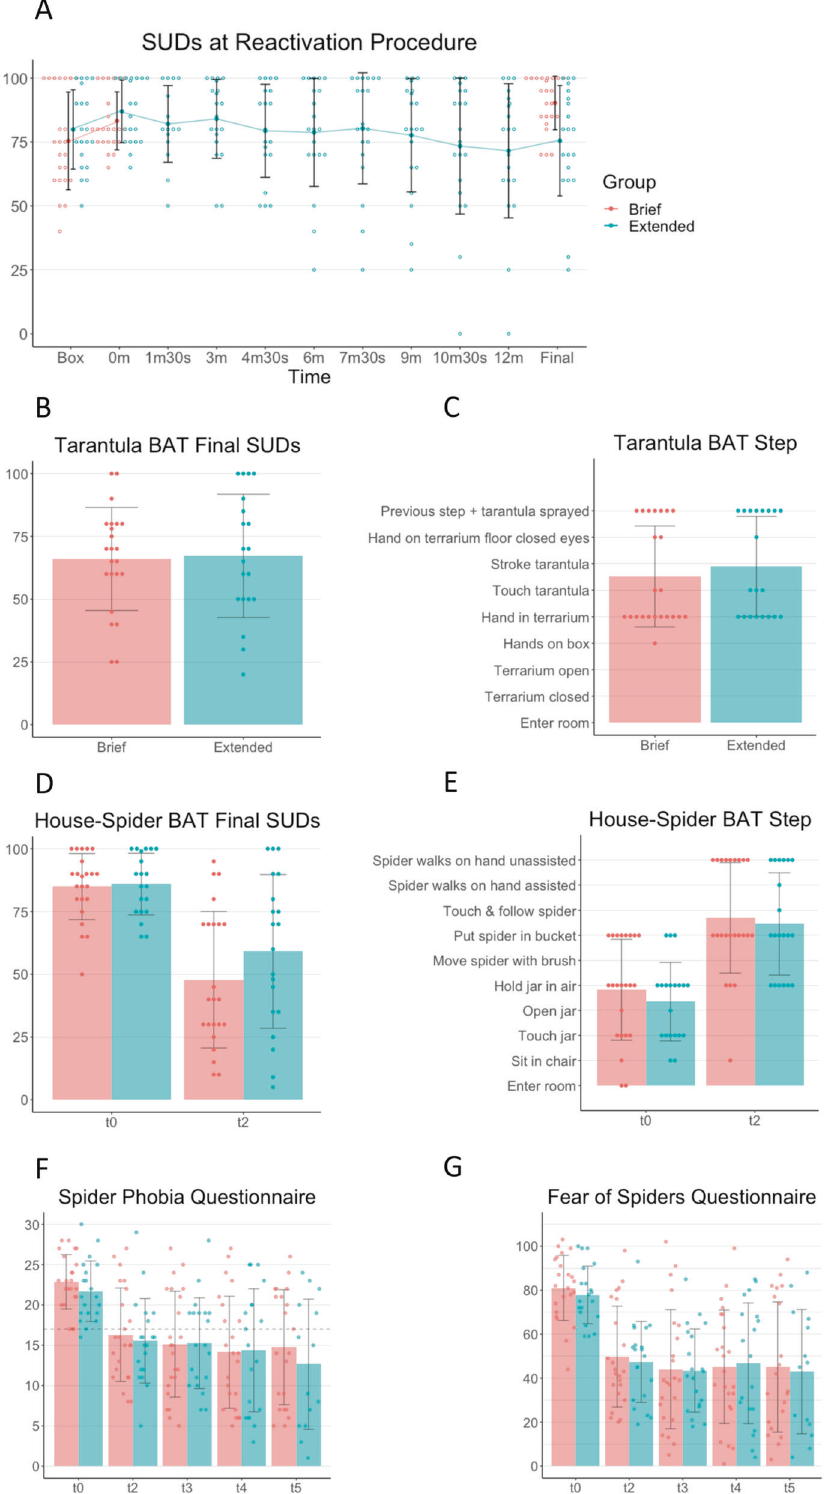
reconsolidation affects behavioural and cognitive fear expression differently, reducing the behavioural fear response (i.e., the fear- potentiated startle) immediately after a night of sleep, while cognitive expression of fear (i.e., shock expectancy ratings) remains unchanged [26]. Contrastingly, we found that